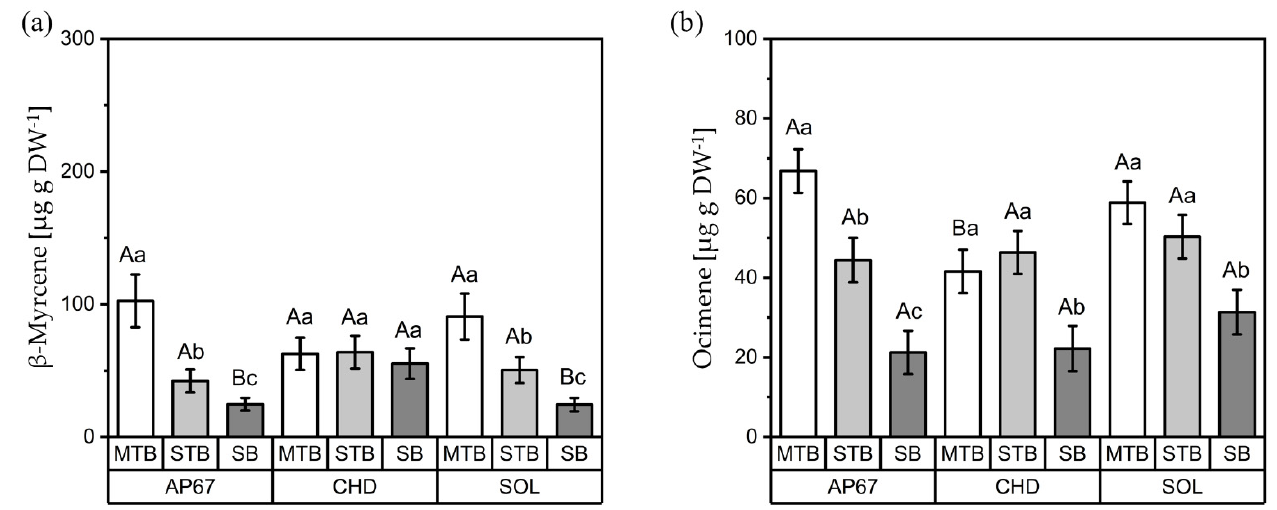
Figure 6. Concentrations ( µ g g DW -1 ) of β -myrcene ( a ) and ocimene ( b ) for the different flower positions (MTB: main top bud, SBs: side buds, STBs: side top buds) under the three light spectra (SOL, AP67 and CHD). Means covered by at least one identical letter did not differ significantly, as indicated by a Tukey test ( α = 0.05). Lowercase letters indicate comparisons between flower positions within light spectra; uppercase letters indicate comparisons between light spectra within flower positions. Error bars indicate the standard errors of the means ( n = 3).